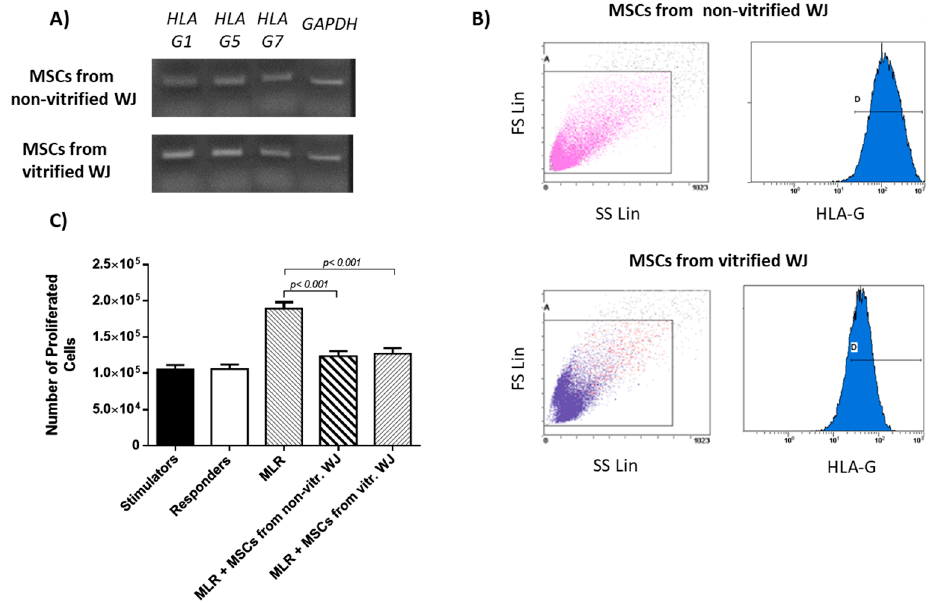
Figure 5. HLA-G expression by WJ-MSCs. ( A ) HLA-G expression of MSCs derived from non-vitrified (n = 5) and vitrified (n = 5) WJ tissue; ( B ) Characterization of HLA-G expression in MSCs derived from non-vitrified (n = 3) and vitrified (n = 3) WJ tissue, by flow cytometric analysis. ( C ) Mixed lymphocyte reaction using WJ-MSCs from both experimental conditions. Statistically significant differences were observed between MLR and MLR coupled with MSCs from non-vitrified WJ tissue ( p < 0.001) and MSCs from vitrified WJ tissue ( p < 0.001).